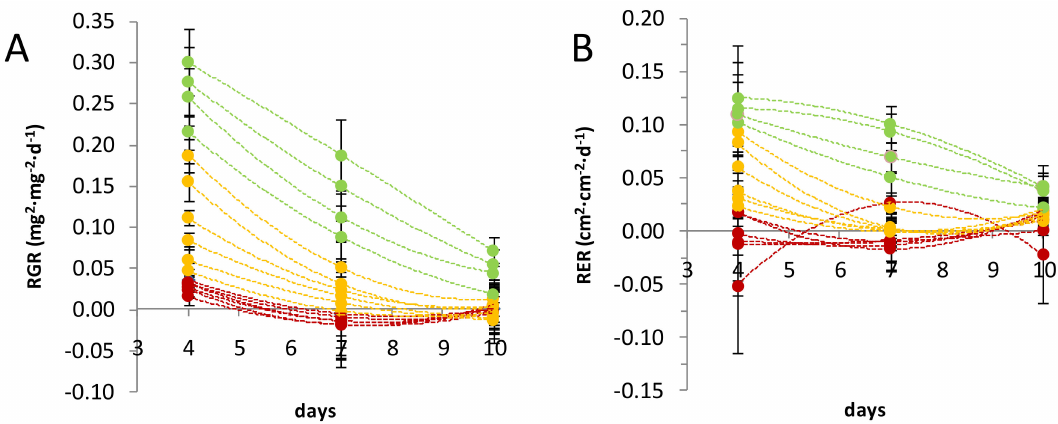
Figure 1. Relative growth rate (RGR) and relative expansion rate (RER) of leaf populations. Leaf RGR ( A ) and RER ( B ) trends during a 10-day timeframe were used to discriminate leaf stages of development. Leaf samples (dots) are ordered following their numerical sequence. From the top to the bottom, leaves: 59–60, 57–58, 55–56, 51–52, 47–48, 43–44, 39–40, 35–36, 31–32, 27–28, 23–24, 19–20, 15–16, 11–12, 7–8, and 3–4. Three di ff erent populations of leaves were defined as young (green), transition (yellow), and mature (red). RGR and RER values were calculated between days 0 and 4, 4 and 7, and 7 and 10. For every leaf sample, n =